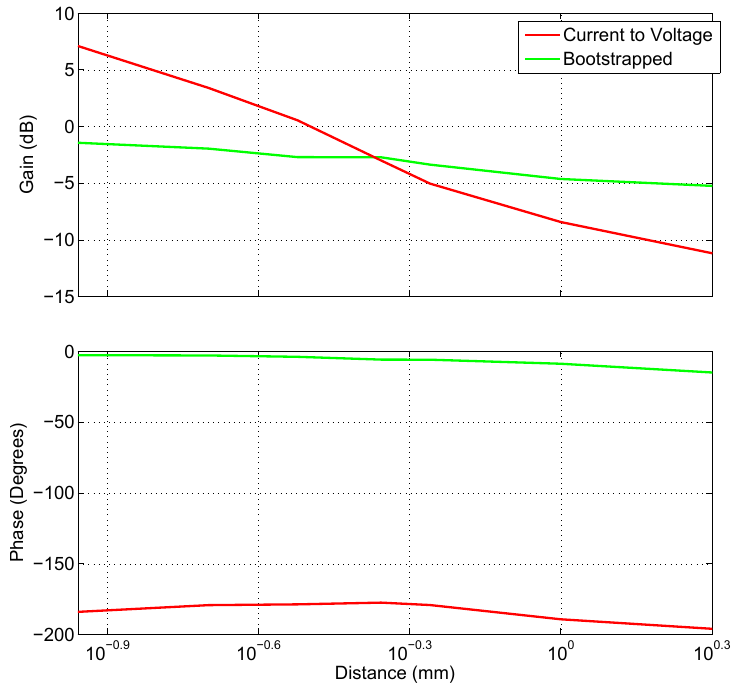
Figure 6. The gain at 10 Hz and phase at measured at 10 Hz with varying distances for the current-to-voltage converter (Red) and Bootstrapped electrode